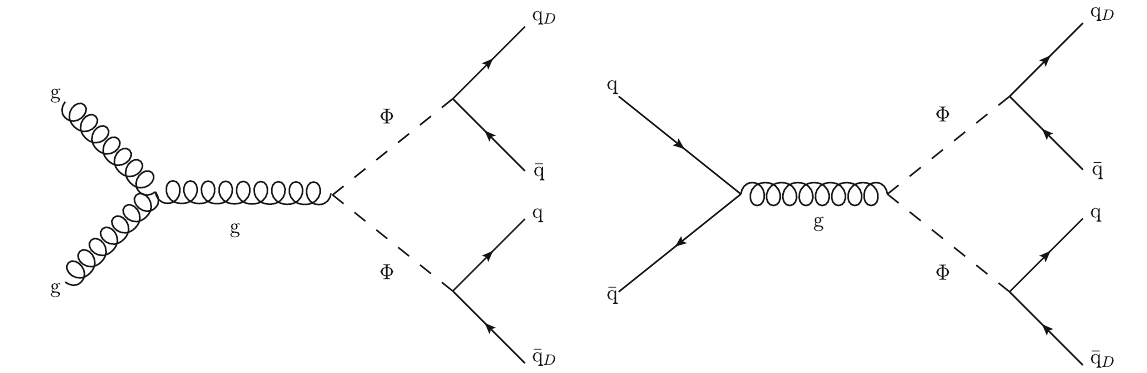
Fig. 3 Diagram for the pair production of mediators and the subsequent decay to dark and SM quarks